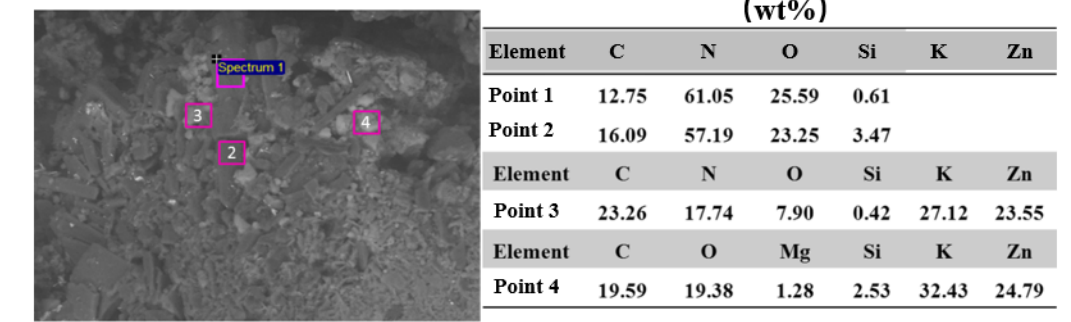
Figure 11. SEM-BSE image of kiln scarring and corresponding energy spectrum analysis results.